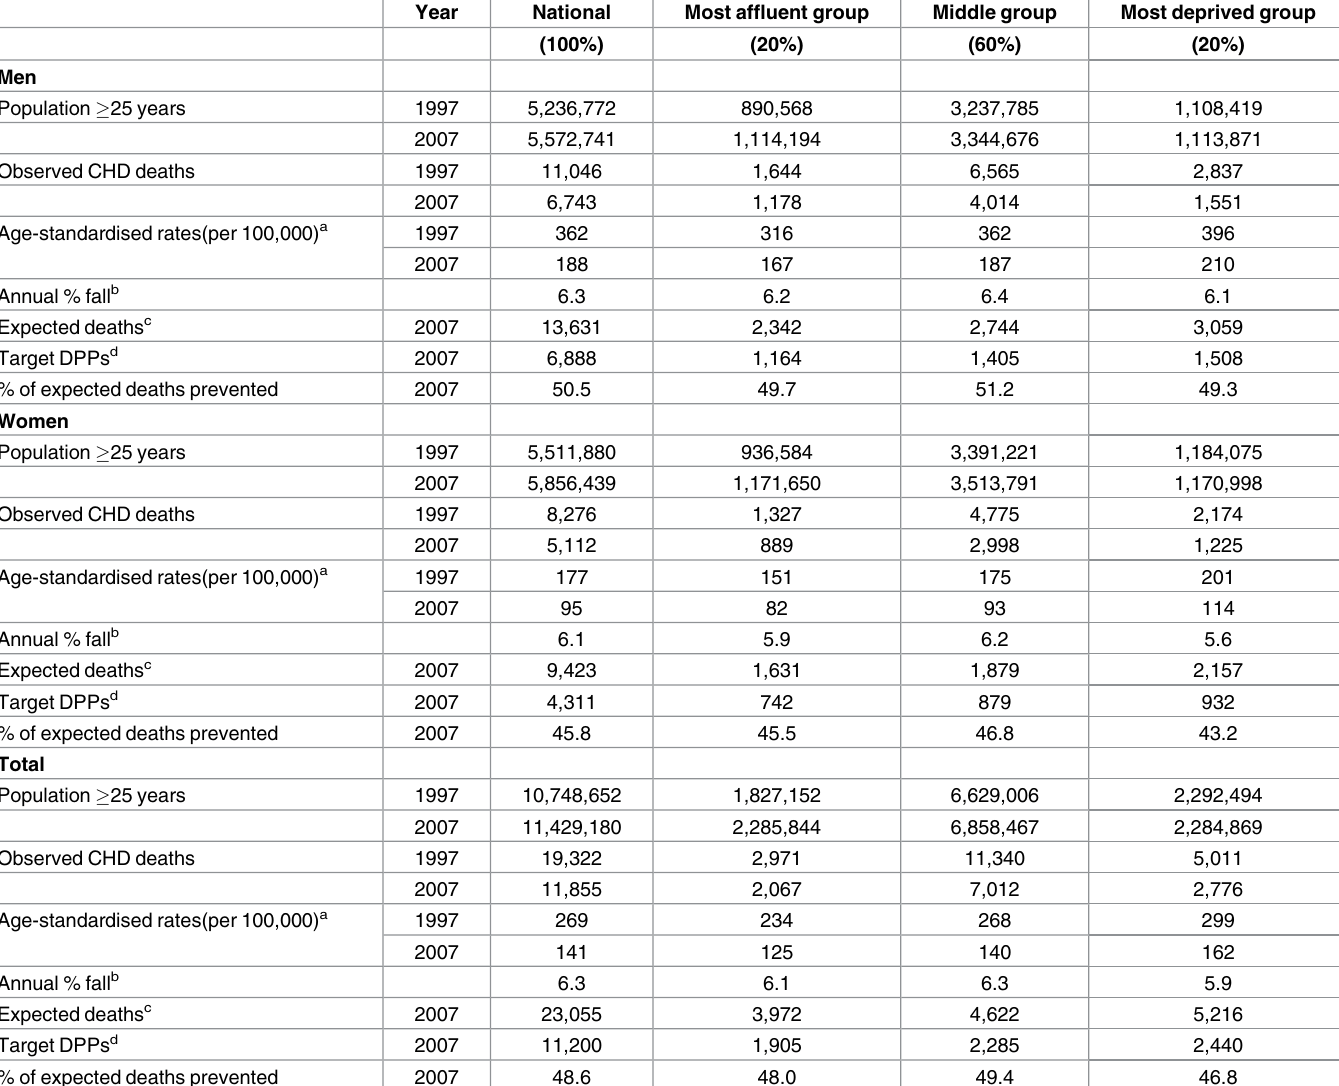
Table 2. CHD mortality rates 1997 and 2007 by sex and socioeconomic